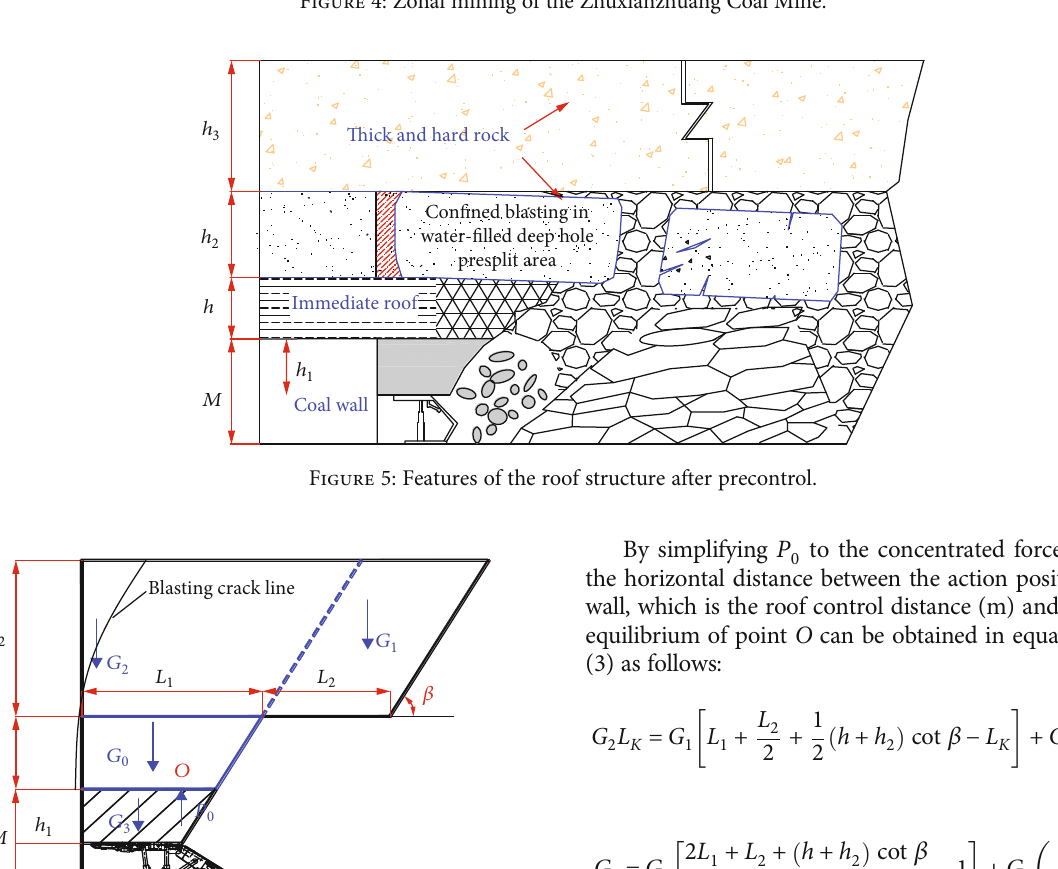
Figure 4: Zonal mining of the Zhuxianzhuang Coal